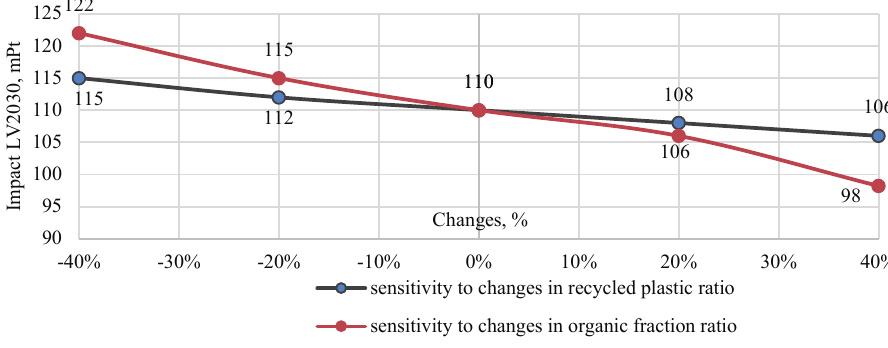
Fig. 3. Results of the sensitivity analysis of LV2030